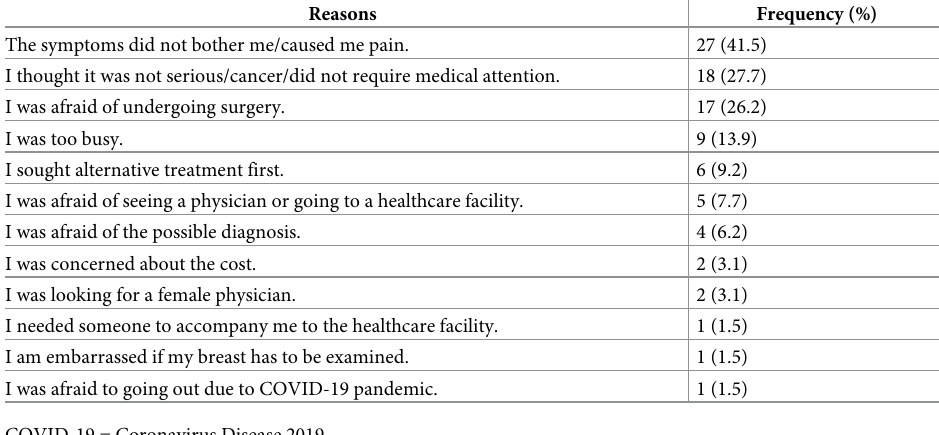
Table 6. Reasons provided by breast cancer patients for delays of � 3 months’ presentation (n =